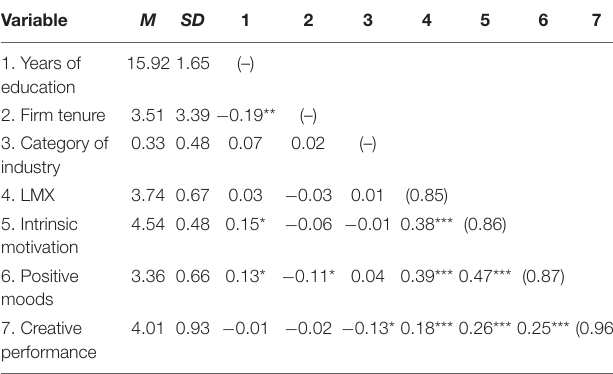
TABLE 1 | Means, standard deviations, and correlations between the study variables.